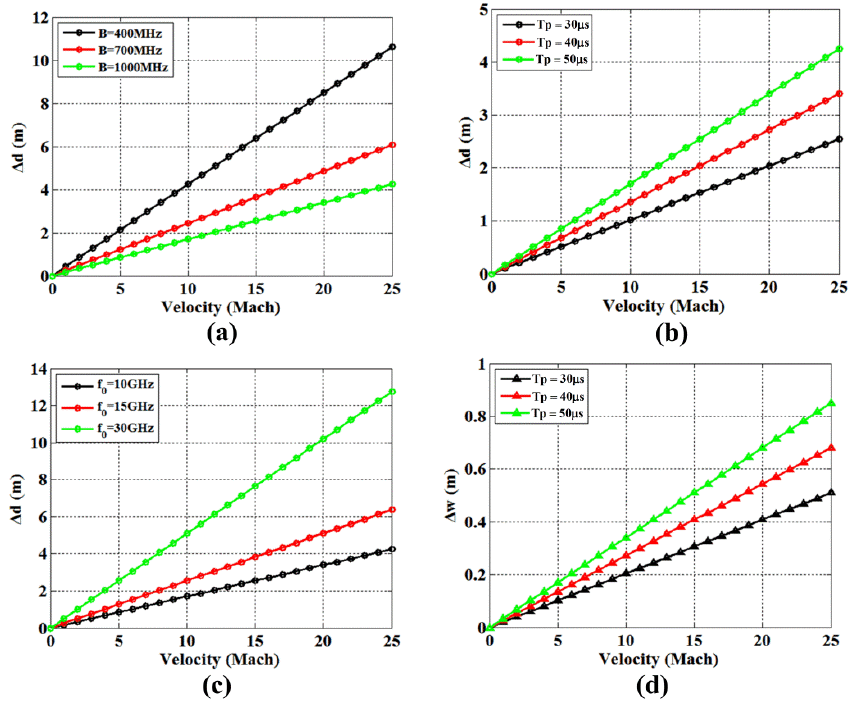
Figure 16. The displacement and diffusion of the scattering point in a one-dimensional range profile with different radar parameters. ( a ) The displacement when f 0 = 10 GHz and T p = 50 µ s. ( b ) The displacement when f 0 = 10 GHz and B = 1 GHz. ( c ) The displacement when T p = 50 µ s and B = 1 GHz. ( d ) The diffusion with different pulse widths. An analysis of the one-dimensional range profiles of a hypersonic target at three radar frequencies in various scenes was conducted. Figure 17 illustrates the results of scenes 1, 2, and 3. As a point of reference, the green line represents the one-dimensional range profile of the blunt cone model without plasma sheath. The red, black, and blue lines represent the X-band, Ku-band, and Ka-band range profiles of the blunt cone mod- el enveloping plasma sheath, respectively. The displacement of a one-dimensional range profile can be exacerbated by a rise in altitude and frequency. As shown in Figure 17a–c, the stagnation point has the greatest offset, and in some cases, it will be far from other scattering points. As the altitude increases, the diffusion phenomenon in the one-dimensional range profile diminishes, but the displacement problem is worse. Figure 17. One-dimensional range profiles of the hypersonic target in scenes 1, 2, and 3. ( a ) Altitude is 30 km. ( b ) Altitude is 40 km. ( c ) Altitude is 50 km.